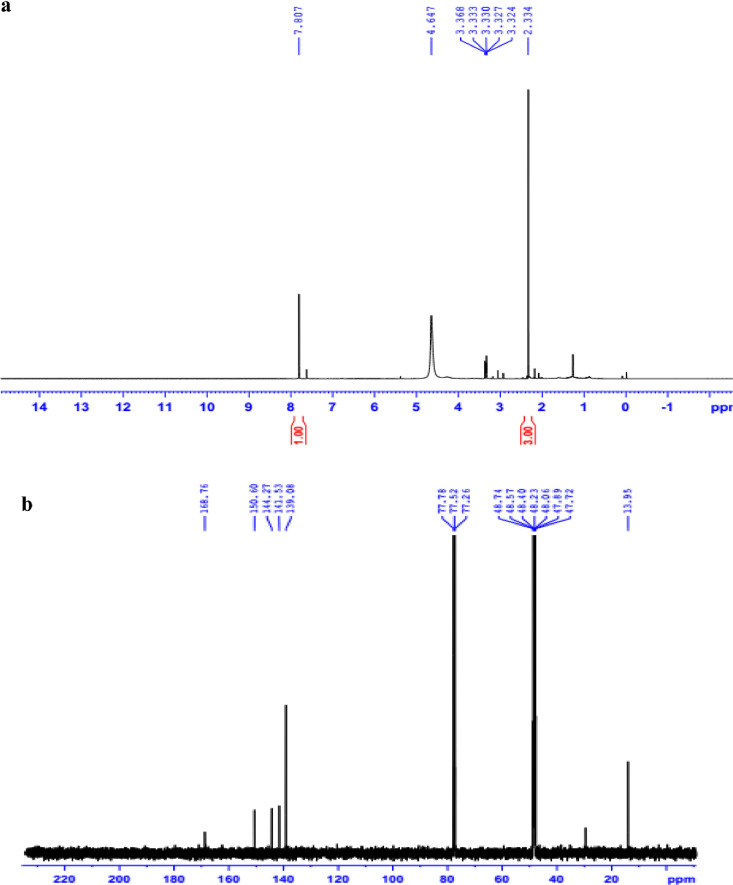
a. 1H NMR (500 MHz, CDCl3+CD3OD) of 2, b. 13C NMR (125 MHz, CDCl3+CD3OD) of 2.